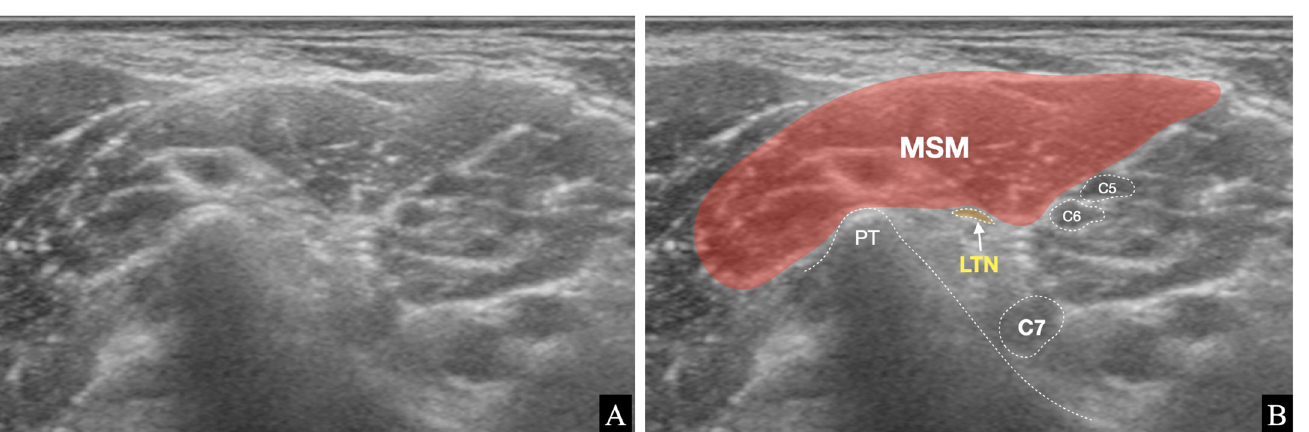
Figure 4. A case that the long thoracic nerve (LTN)’s location is outside of the middle scalene muscle (MSM). ( A ) A pure ultrasound image without indications of structures. ( B ) The posterior tubercle (PT), MSM, LTN, and C5–7 nerve roots are indicated on the ultrasound image.